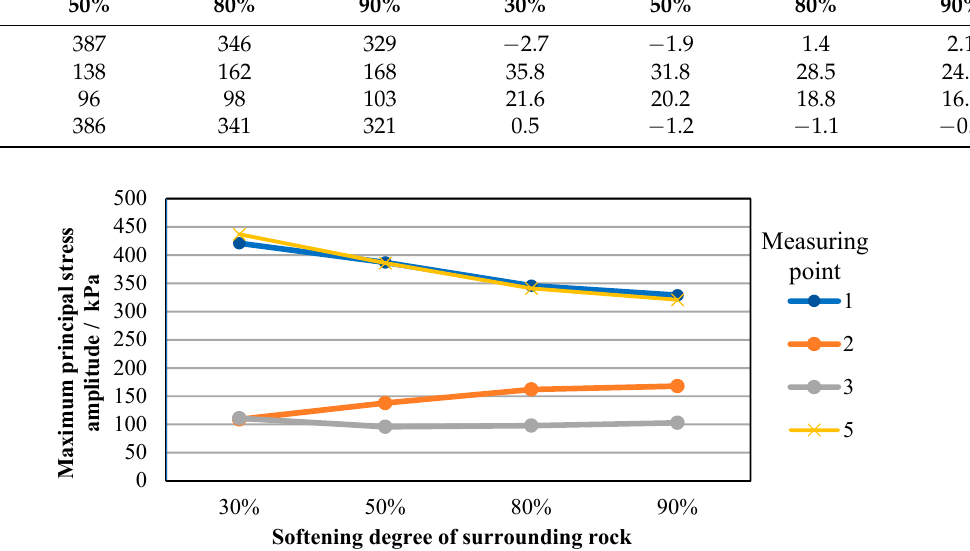
Figure 12. Maximum principal stress amplitude diagram of measuring points 1, 2, 3, and 5 under different softening degrees of basement surrounding rock.